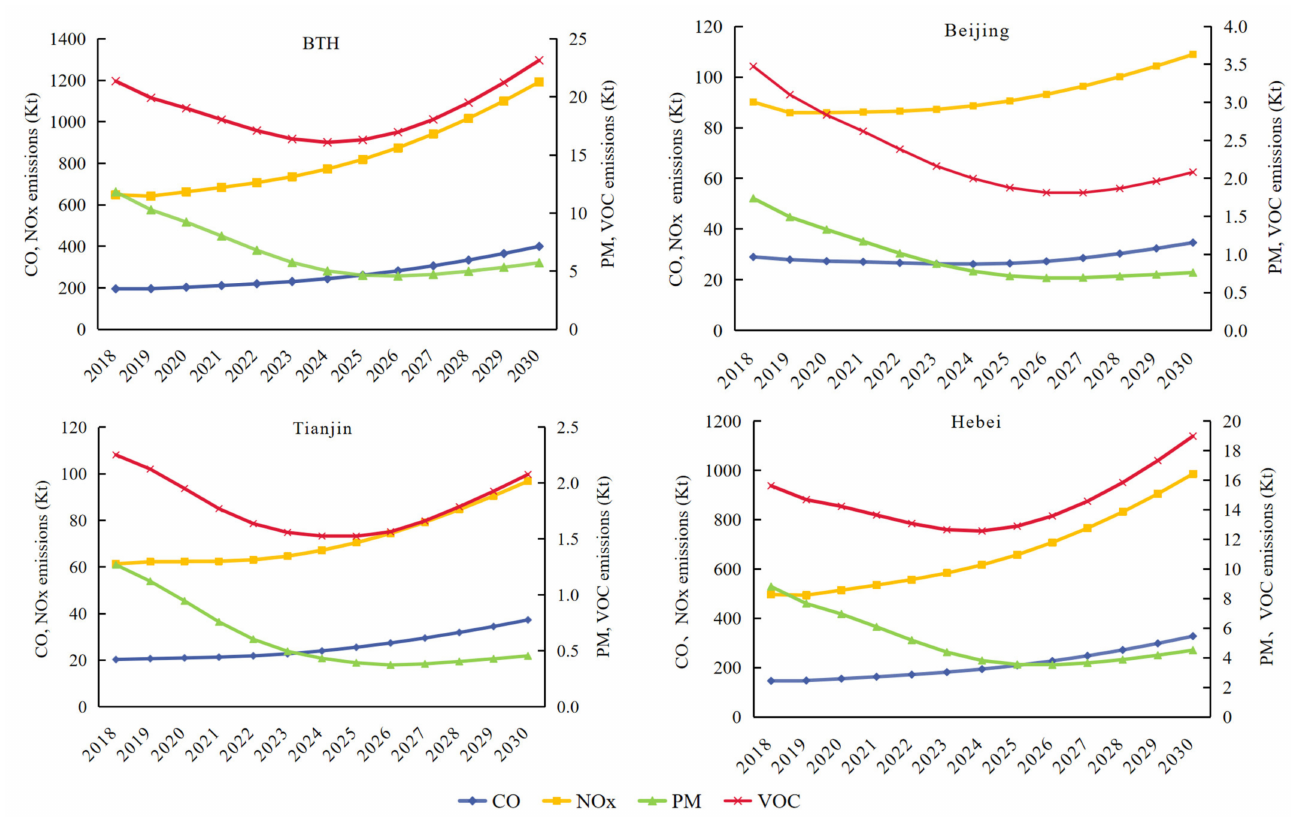
Figure 2. Diesel vehicle pollutant emissions under the BAU scenario in the BTH